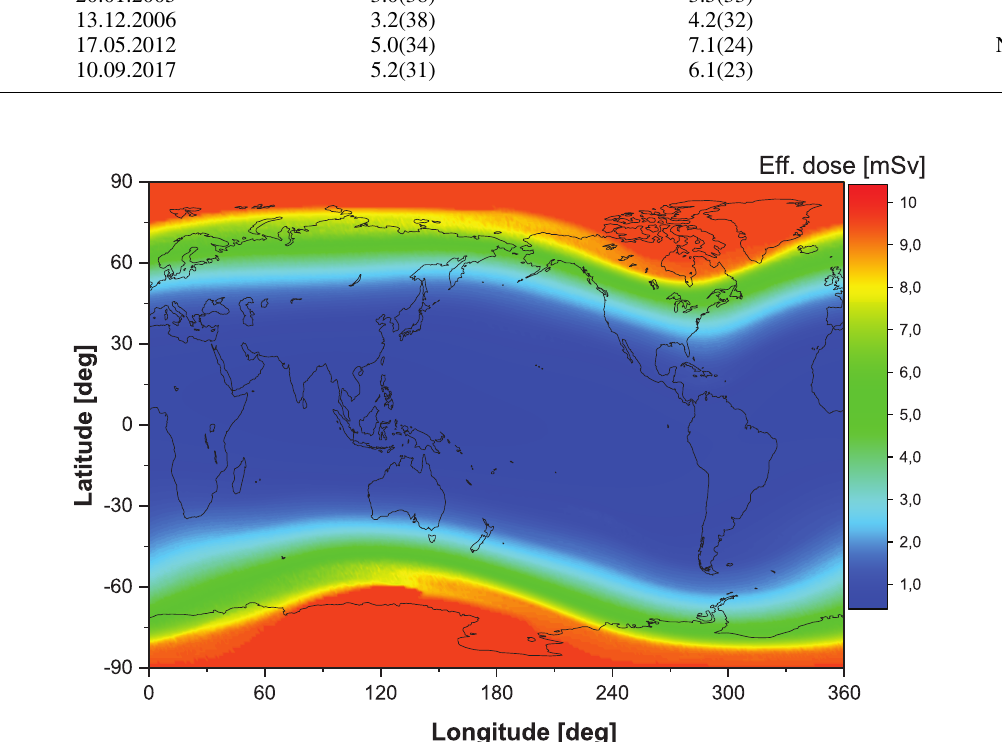
Fig. 4. Global map of the effective dose at altitude of 40 kft during GLE #5 integrated over the fi rst four hours of the